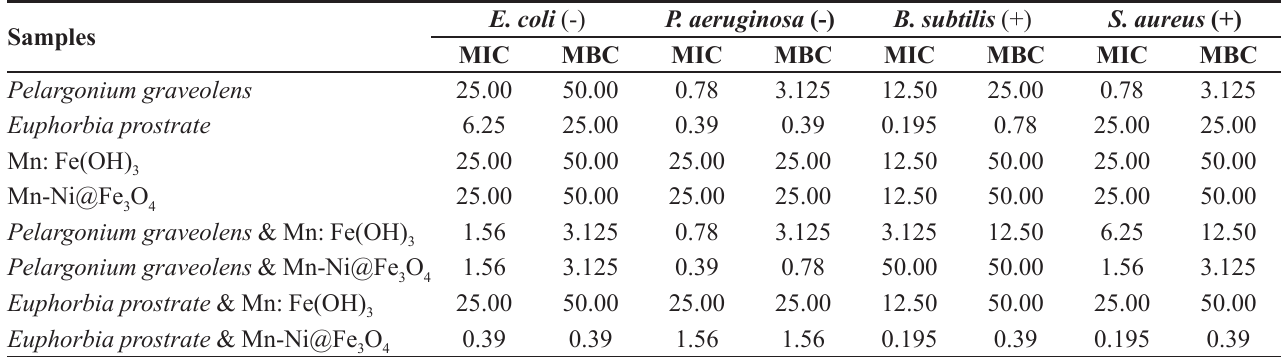
TABLE IV - Antibacterial effects of extract and nanoparticles performed by Broth dilution (MIC (mg/mL) and MBC (mg/mL) methods Samples